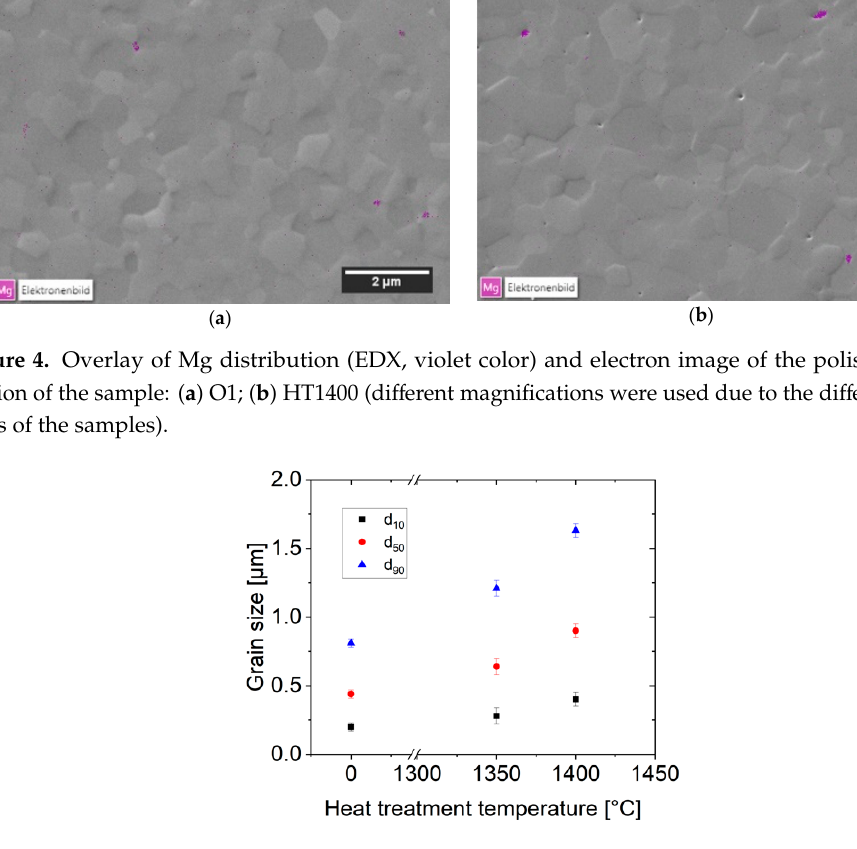
Figure 5. Influence of the heat treatment temperature on the grain size of alumina ceramic.